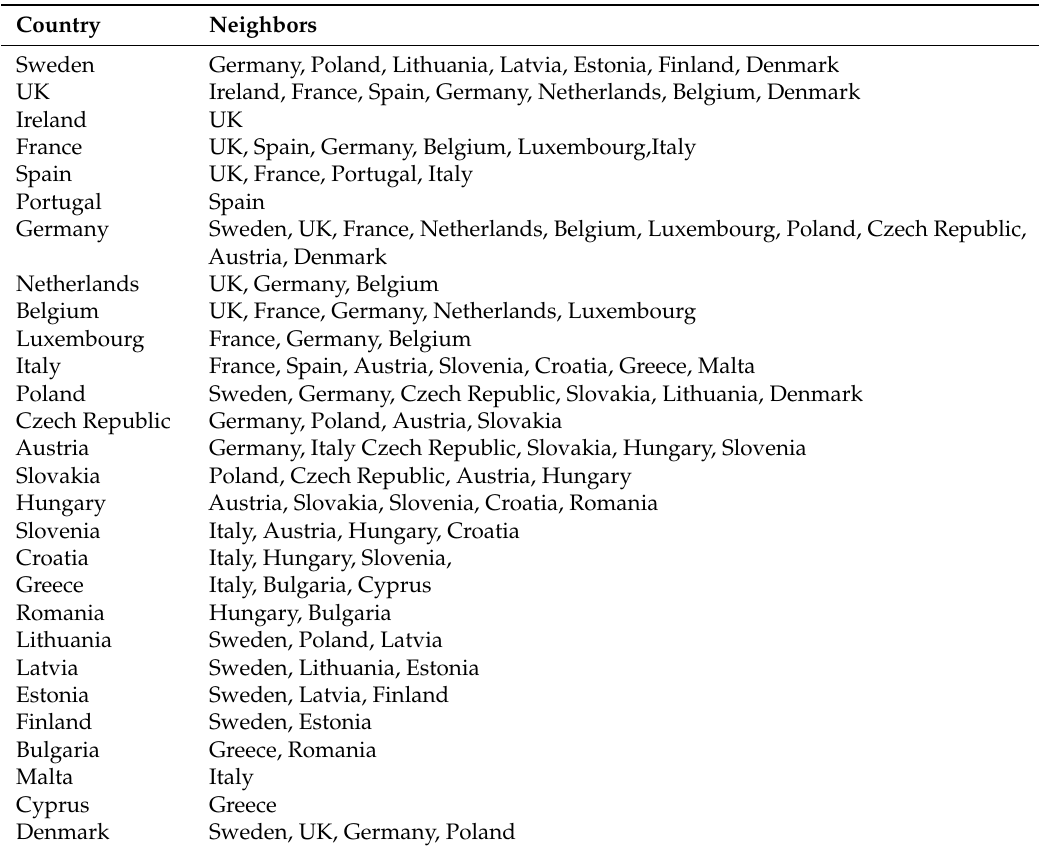
Table 1. Overview of Neighbors of all